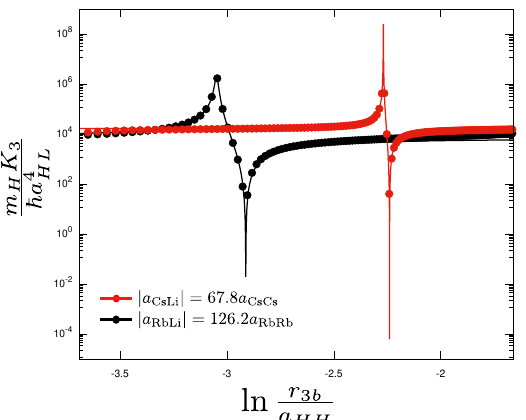
Figure 7. A comparison of the scaled recombination coefficient obtained via the fitting of Equation (15) (points) and the Fano lineshape formula (solid lines) from Equation (16) for two HHL systems. The red points and lines correspond to 6 Li- 133 Cs - 133 Cs for a scattering length ratio points and lines denote the 6 Li- 87 Rb - 87 Rb system at is set to zero.